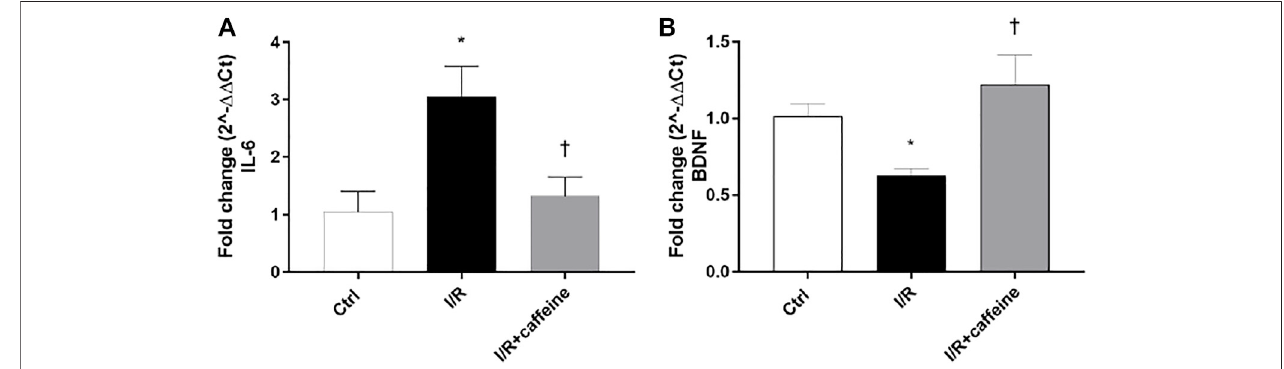
FIGURE 8 | Caffeine counteracts in fl ammation and elicits the BDNF expression in I/R mice. After 72 h, caffeine was able to revert the upregulation of IL-6 mRNA levels (A) elicited by I/R damage in mouse retinas. BDNF mRNA levels were upregulated by caffeine, compared to I/R mice (B) . Values were reported as mean ± SD; n (cid:1) 4. Data were analyzed by one-way ANOVA and the Tukey post hoc test for multiple comparisons. * p < 0.05 vs. control; † p < 0.05 vs.